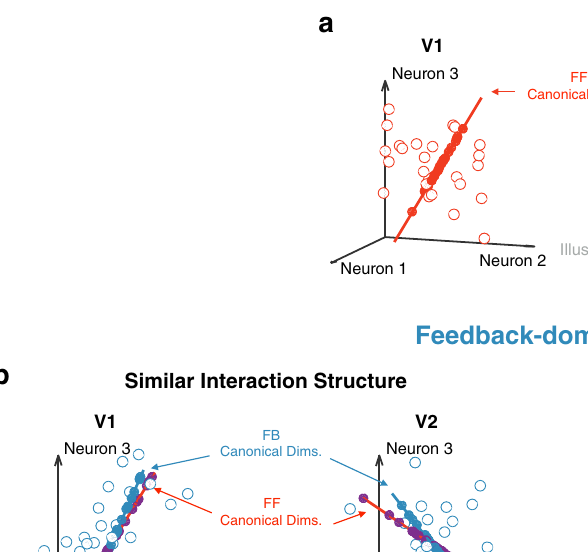
FF Dims Pop. Corr. FB Dims Pop. Corr.